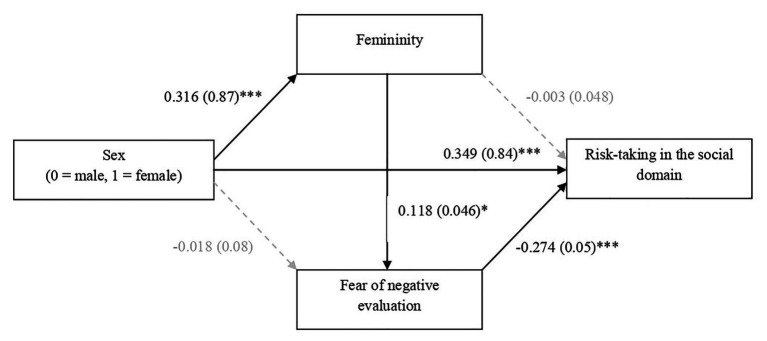
Serial mediation model depicting indirect effect sex (0 = male, 1 = female) on social risk-taking through femininity and fear of negative evaluation. Unstandardized beta coefficients reported, with standard errors within parentheses. *p < 0.05, ***p < 0.001.